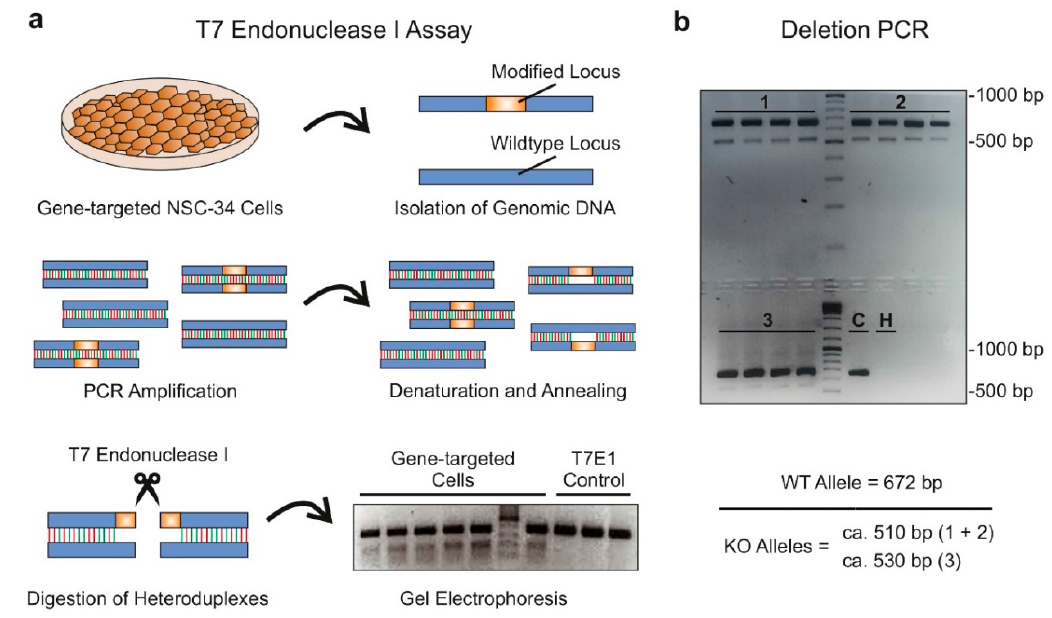
Figure 2. In vitro validation of single guide RNA (sgRNA) activity: ( a ) Schematic representation depicting the workflow of T7 endonuclease I (T7E1) assays. To detect genome-editing events induced by functional sgRNAs, genomic DNA is isolated from gene-targeted cells and the locus of interest is amplified via PCR. After denaturation and random re-annealing of DNA strands, the PCR products are incubated with T7E1, which results in cleavage of DNA heteroduplexes consisting of unmodified and gene-targeted DNA strands. Cleaved heteroduplexes can be detected by gel electrophoresis and demonstrate successful gene-editing by functional sgRNAs. To control for T7E1-specific appearance of additional bands, PCR products that have not been subjected to T7E1 digestion are also run on the same gel electrophoresis (T7E1 control). ( b ) Representative agarose gel displaying PCR reactions with primers flanking exon 1 of lncRNA Gm15441 using genomic DNA isolated from NSC-34 cells transfected with different combinations of sgRNAs, including [1] Gm15441-5 ′ -2 (20) + Gm15441-3 ′ -2 (18) , [2] Gm15441-5 ′ -1 (18) + Gm15441-3 ′ -2 (18) and [3] Gm15441-5 ′ -2 (18) + Gm15441-3 ′ -2 (18) . C, negative control PCR using genomic DNA from untransfected NSC-34 cells. H, H 2 O control PCR